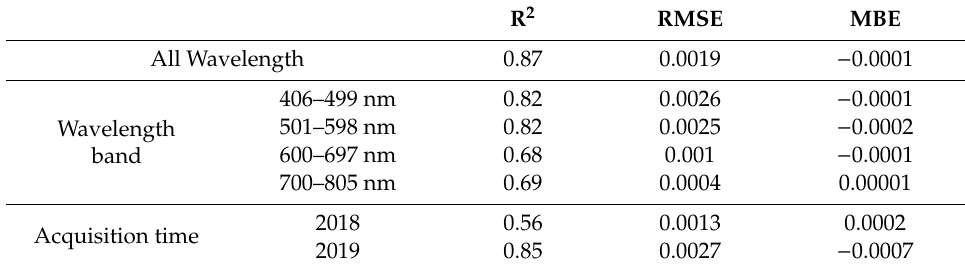
Table 3. The coe ffi cient of determination (R 2 ), root mean square error (RMSE), and mean bias error (MBE) values between in situ remote-sensing reflectance ( R rs ) and atmospherically corrected R rs for each wavelength range and acquisition time using the quick atmospheric correction (QUAC) method combined with the empirical line (EL) method. R 2 RMSE MBE All Wavelength 0.87 0.0019 − 0.0001 406–499 nm 0.82 0.0026 − 0.0001 501–598 nm 0.82 0.0025 − 0.0002 Wavelength 600–697 nm 0.68 0.001 − 0.0001 band 700–805 nm 0.69 0.0004 0.00001 2018 0.56 0.0013 0.0002 Acquisition time 2019 0.85